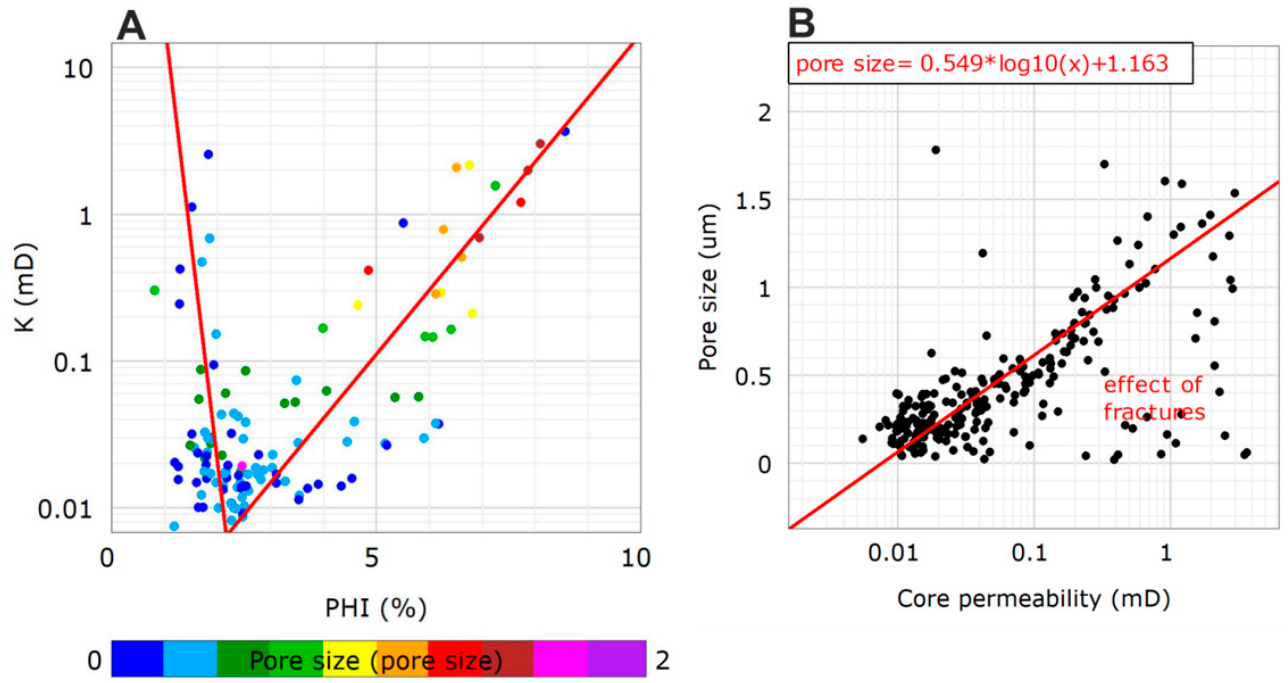
Figure 4. Cross-plot of laboratory-measured ( A ) porosity and permeability in well W-3, with the color scale referring to Figure 4. Cross ‐ plot of laboratory ‐ measured ( A ) porosity and permeability in well W ‐ 3, with the color scale referring to dynamic Young’s modulus values, and ( B ) average pore sizes and dynamic Young’s modulus values, and ( B ) average pore sizes and permeability.